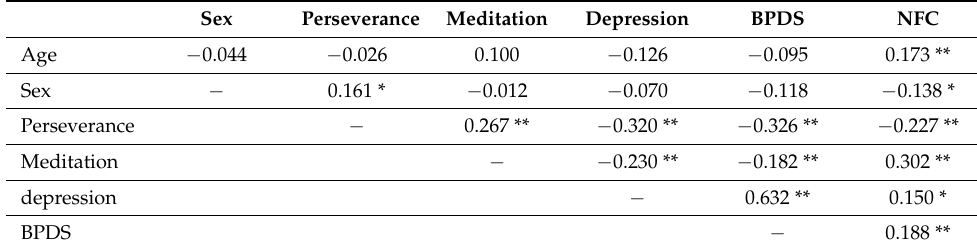
Table 2. Zero order correlation between variables.